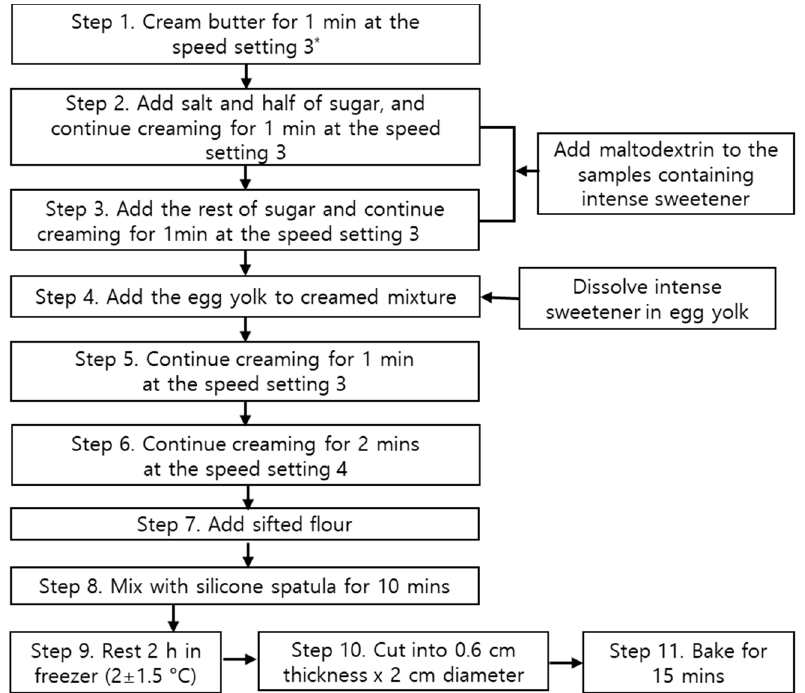
Figure 1. Cookie preparation procedure. * Food Mixer (HB-125, Sanshui Hop Shing Metal & Plastic Manufactory Ltd., Foshan, China).